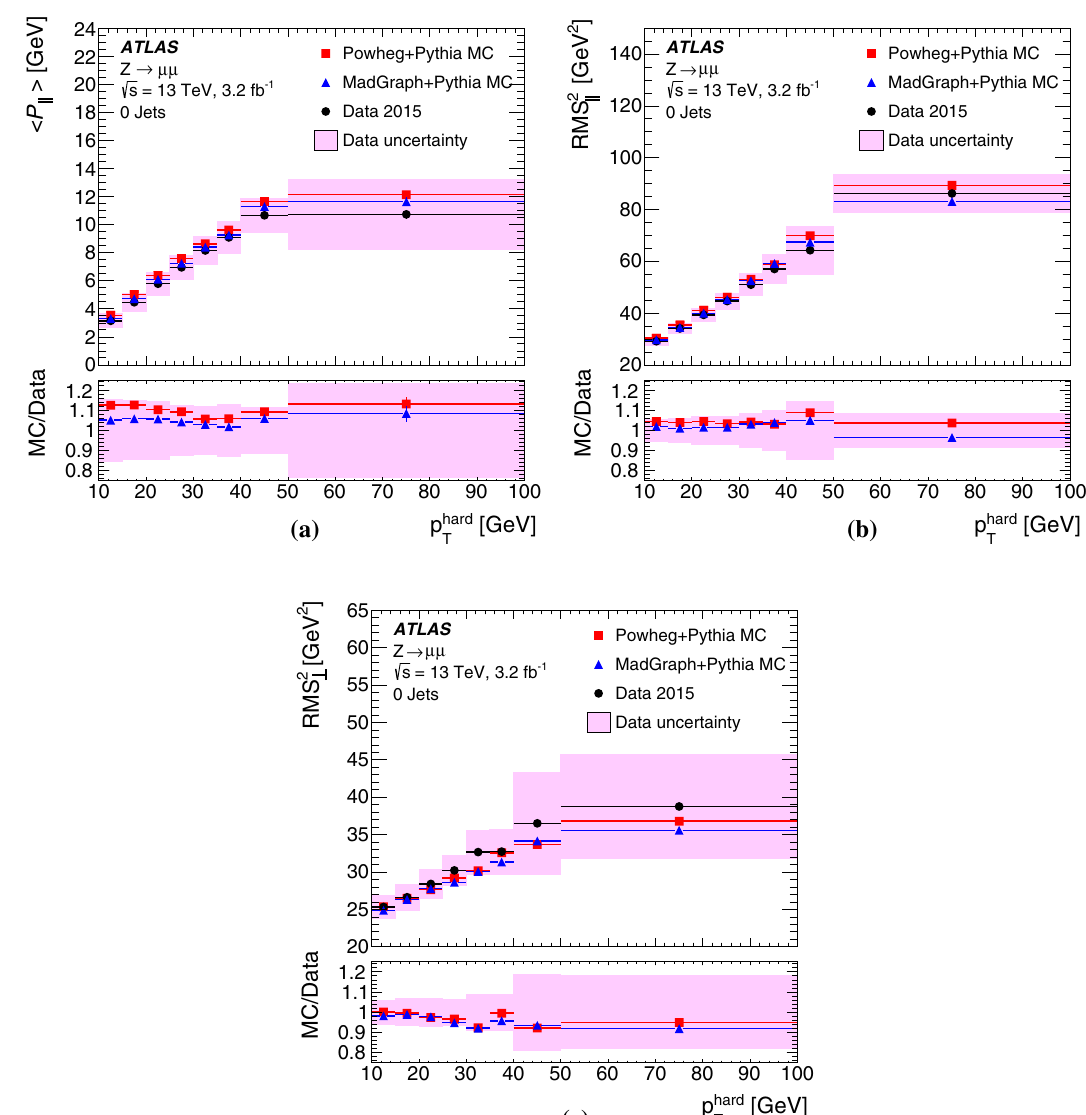
Fig. 13 The a average value of the longitudinal projection (cid:8) P (cid:7) (cid:9) and the b variance RMS 2 (cid:7) of the longitudinal projection P (cid:7) of p soft p hard for Z → μμ event with N jet = 0, for data and two different T MC simulations, shown as a function of p hard